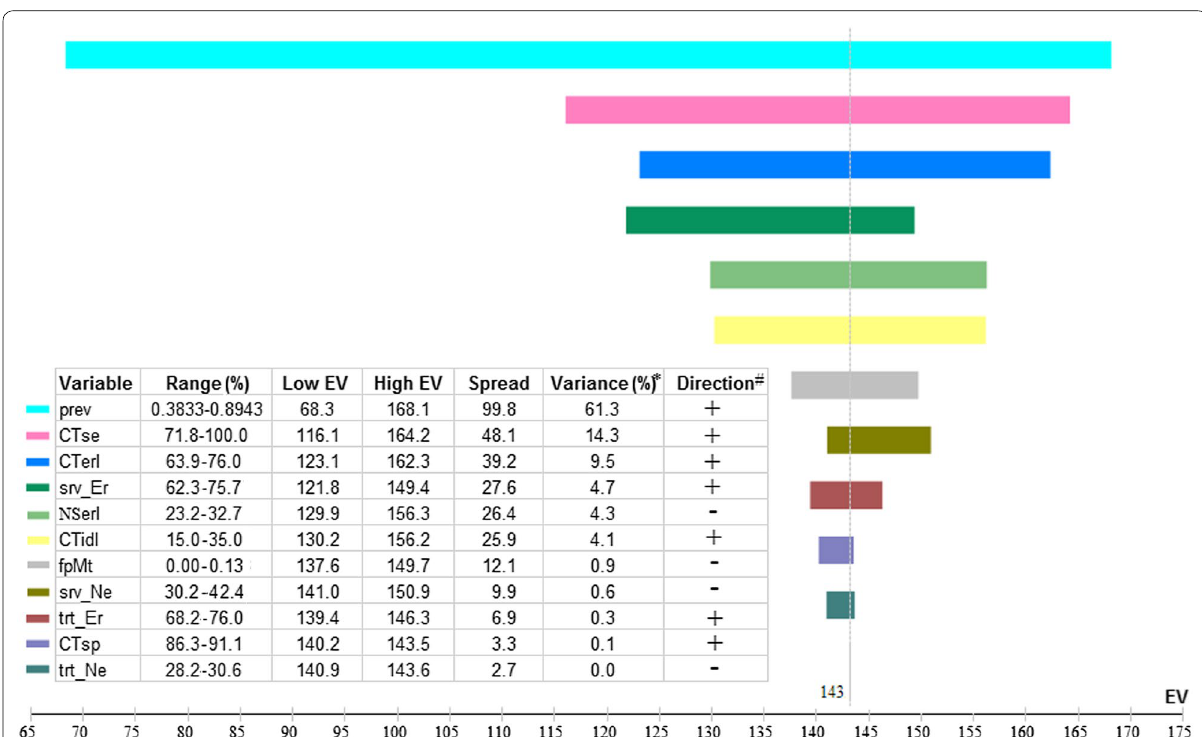
Fig. 2 Tornado histogram of lung cancer deaths in the low-dose CT screening scenario over the no screening scenario. EV effect value, horizontal line represents the relative difference in lung cancer deaths with low-dose CT screening over no screening (the higher the EV, the higher the screen- ing benefits), and vertical dash line indicates the location of estimated average EV, prev lung cancer prevalence in the screened cohort, CTse sensitiv- ity of low-dose CT, CTerl proportion of early-stage cancers among lung cancers detected with low-dose CT, srv_Er survival possibility of patients with resected early-stage lung cancers, NSerl proportion of early-stage cancers among lung cancers detected with no screening, CTidl proportion of indolent cancers among lung cancers detected with low-dose CT, fpMt death possibility due to false diagnosis and invasive treatment, srv_Ne survival possibility of individuals with resected non-early-stage lung cancer, trt_Er acceptance rate of surgery for early-stage lung cancers, CTsp specificity of low-dose CT, trt_Ne acceptance rate of surgery for non-early-stage lung cancers. Asterisk the proportion of difference squared between low and high EV for each variable of the sum of differences squared for all variables. The plus sign denotes that the higher the variable value, the greater the reduction in lung cancer deaths with low-dose CT screening over no screening, and the minus sign denotes that the higher the variable value, the smaller the reduction in lung cancer deaths with low-dose CT screening over no